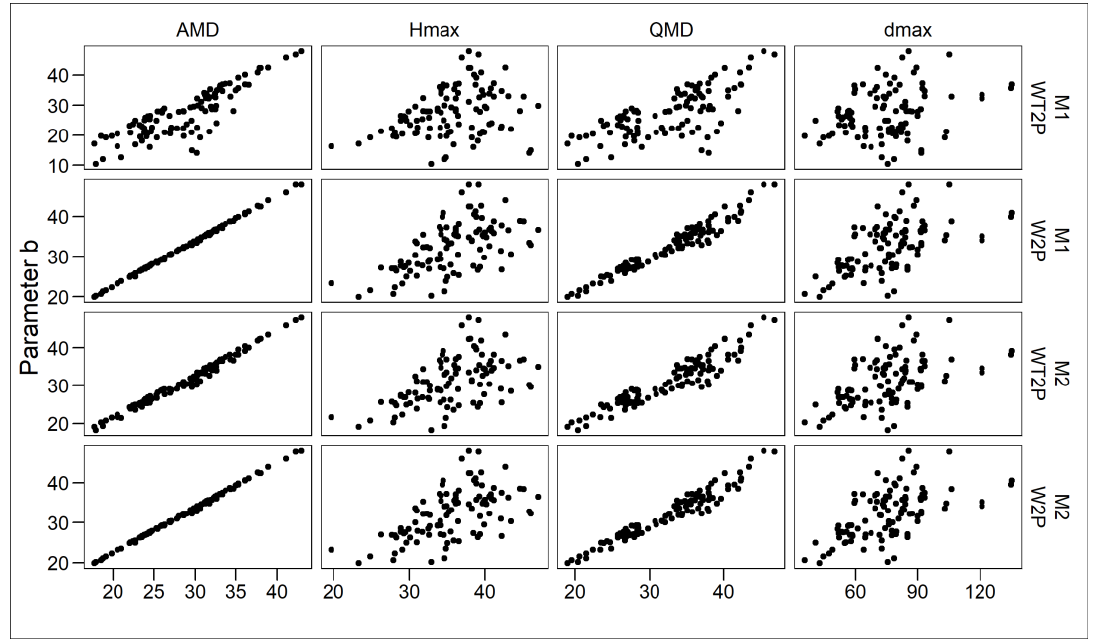
Figure 2. Parameter b variation in relation to stand characteristics. AMD, QMD, and dmax x-axis are in cm while Hmax x-axis is in m.